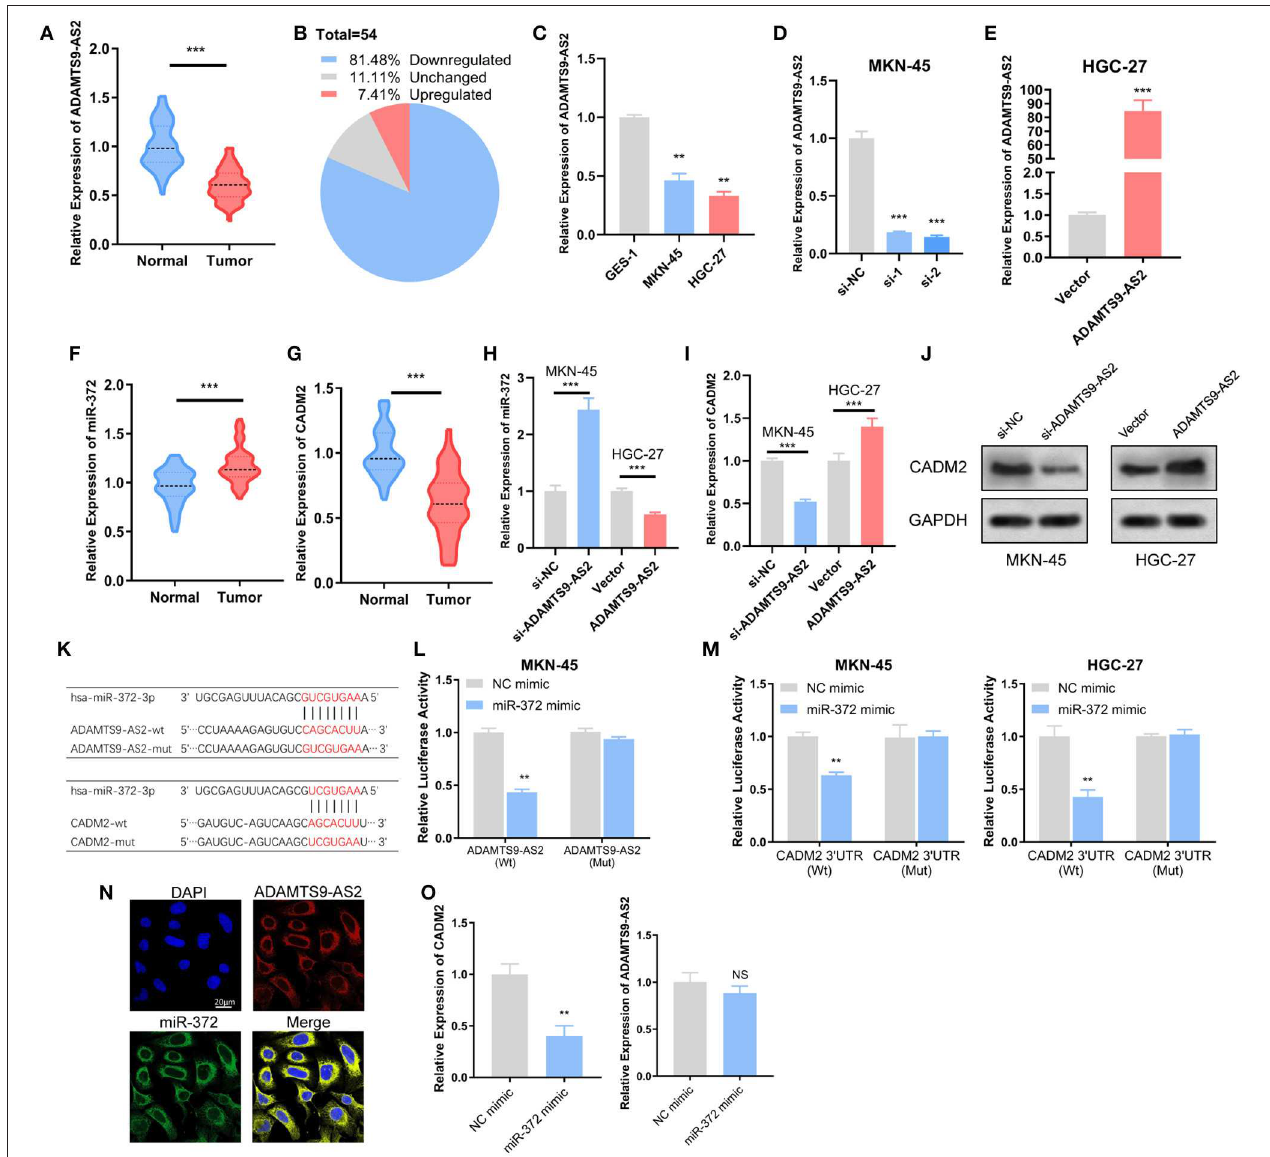
FIGURE 6 | Experimental validation of ADAMTS9-AS2/miR-372/ CADM2 axis. (A,B) ADAMTS9-AS2 was downregulated in GC in comparison with normal tissues ( n = 54). (C) ADAMTS9-AS2 was downregulated in MKN-45 and HGC-27 cells compared with gastric epithelial GES-1 cells. (D,E) ADAMTS9-AS2 was knockdown in MKN-45 cells and overexpressed in HGC-27 cells, the effects of knockdown and overexpression was measured by qRT-PCT. (F,G) miR-372 was upregulated and CADM2 was downregulated in GC compared with normal tissues ( n = 54). (H,I) After knockdown or overexpression of ADAMTS9-AS2, the expression levels of miR-372 and CADM2 were measured in MKN-45 or HGC-27 cells. (J) The protein expression of CADM2 was determined after ADAMTS9-AS2 knockdown or overexpression by western blotting. (K) Schematic representation of the potential binding sites of miR-372 with ADAMTS9-AS2 and the 3 ′ UTR of CADM2. (L,M) The luciferase activities after wild-type or mutant ADAMTS9-AS2 (L) or CADM2 3 ′ UTR (M) luciferase reporter vector was co-transfected with miR-372 mimics into MKN-45 and HGC-27 cells. (N) FISH assay showed the co-localization of ADAMTS9-AS2 and miR-372. (O) The expression levels of ADAMTS9-AS2 and CADM2 after transfection of miR-372 mimic were measured by qRT-PCR. All experiments were performed in triplicate. Scale bar = 20 µ m. * p < 0.05, ** p < 0.01, *** p < 0.001, NS,